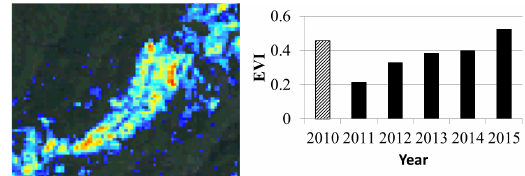
Figure 6: Temporal profile of average Enhanced Vegetation Index for high severity areas (red color) indicating increase of vegetation index over time during recovery (diagonal texture = pre-tornado; solid bar =